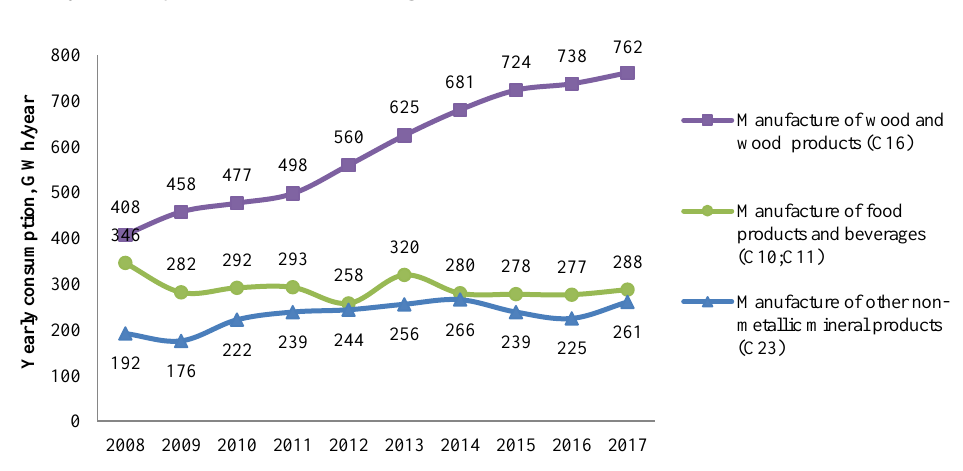
Fig. 1 . Electricity consumption in top 3 most consuming manufacturing sectors in